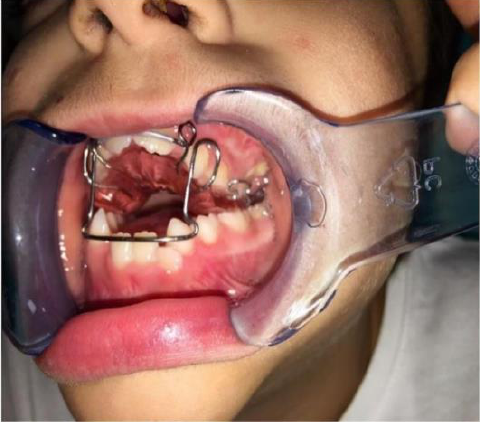
Figure 1. Maxillary Advancement Contention (MAC) Device: it is a functional activator with dental retention.